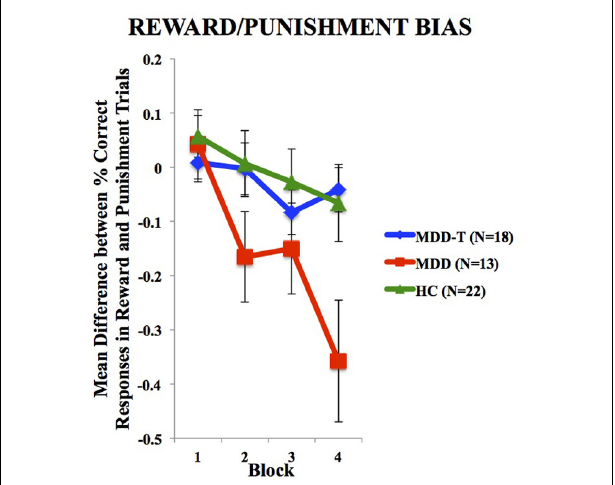
FIGURE 3 | Mean difference between percentage correct responses in reward and punishment trials per block ( ± SEM) . MDD is medication naïve, MDD-T is on medication, and HC is healthy controls.